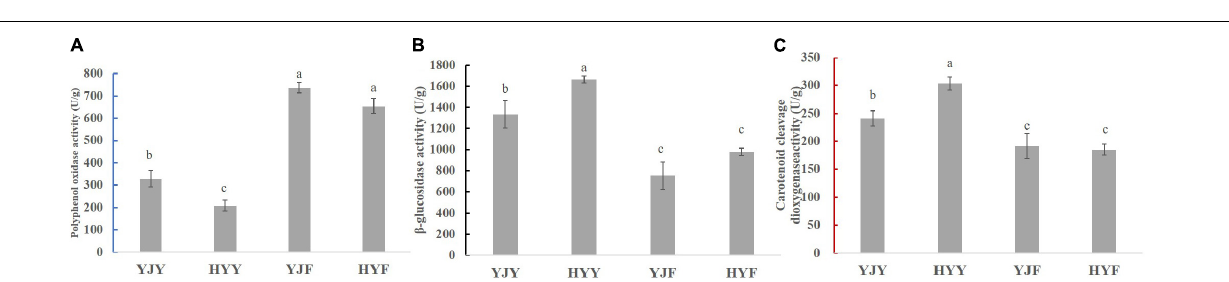
FIGURE 6 | Comparison of enzyme activities in fresh and fermented leaves of “Yinghong 9” and “Huangyu.” (A) Polyphenol oxidase activity of “Yinghong 9” and “Huangyu” leaves. (B) β -glucosidase activity of “Yinghong 9” and “Huangyu” leaves. (C) Carotenoid cleavage dioxygenase activity of “Yinghong 9” and “Huangyu” leaves. All the data are presented as the mean standard deviation ( n = 3). Means with different letters at each treatment represented a significant difference at p ≤ 0.05. YJY was “Yinghong 9” fresh leaves, YJF was “Yinghong 9” fermented leaves; HYY was “Huangyu” fresh leaves, HYF was “Huangyu” fermented